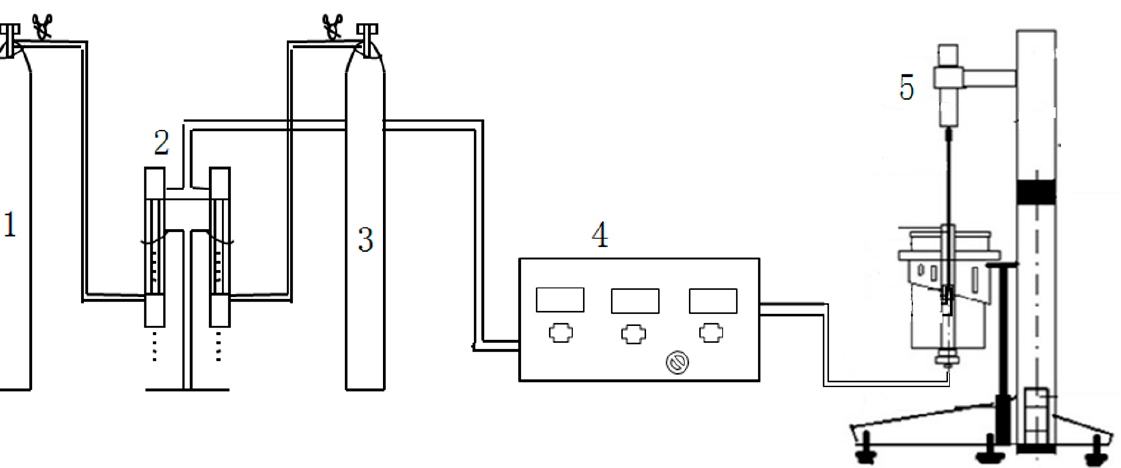
Figure 3. Schematic diagram of the experimental system. 1—H 2 , 2—gas flowmeter, 3—Ar, 4—gas mass flowmeter, 5—Resistance furnace.